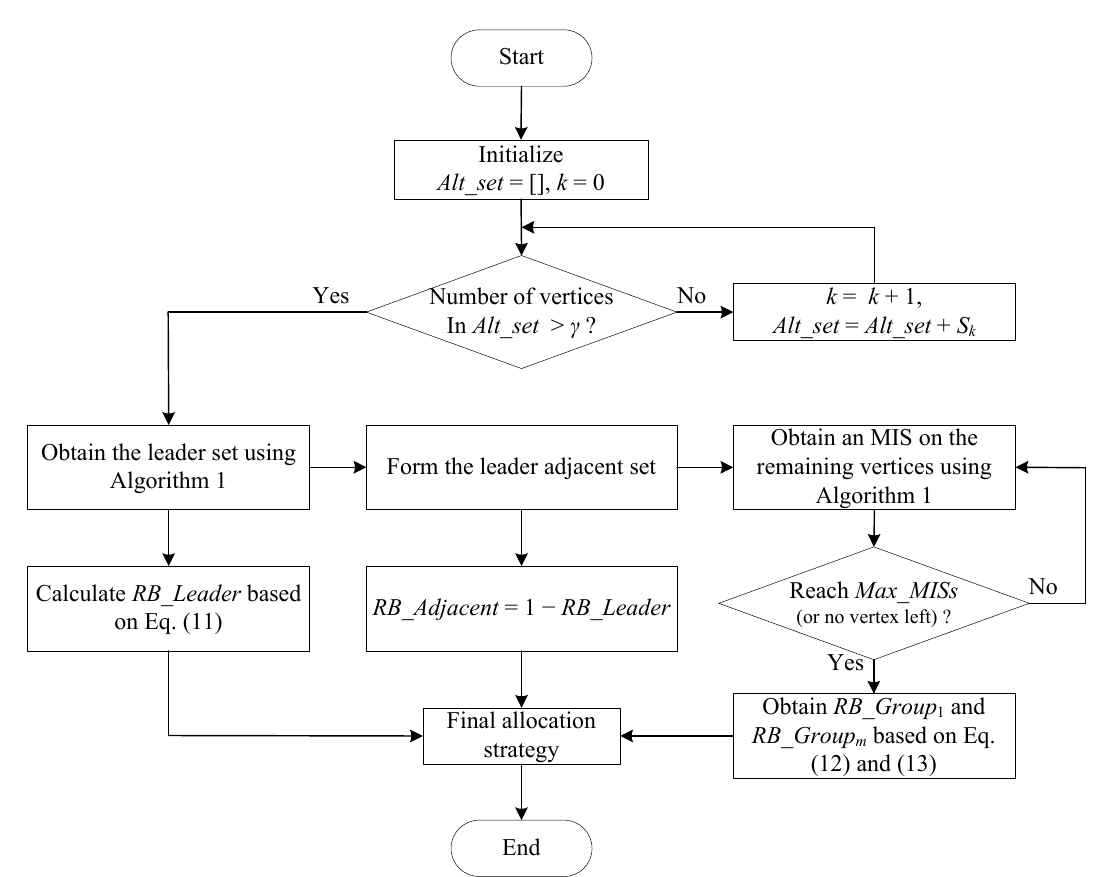
Figure 4. Flowchart of the proposed